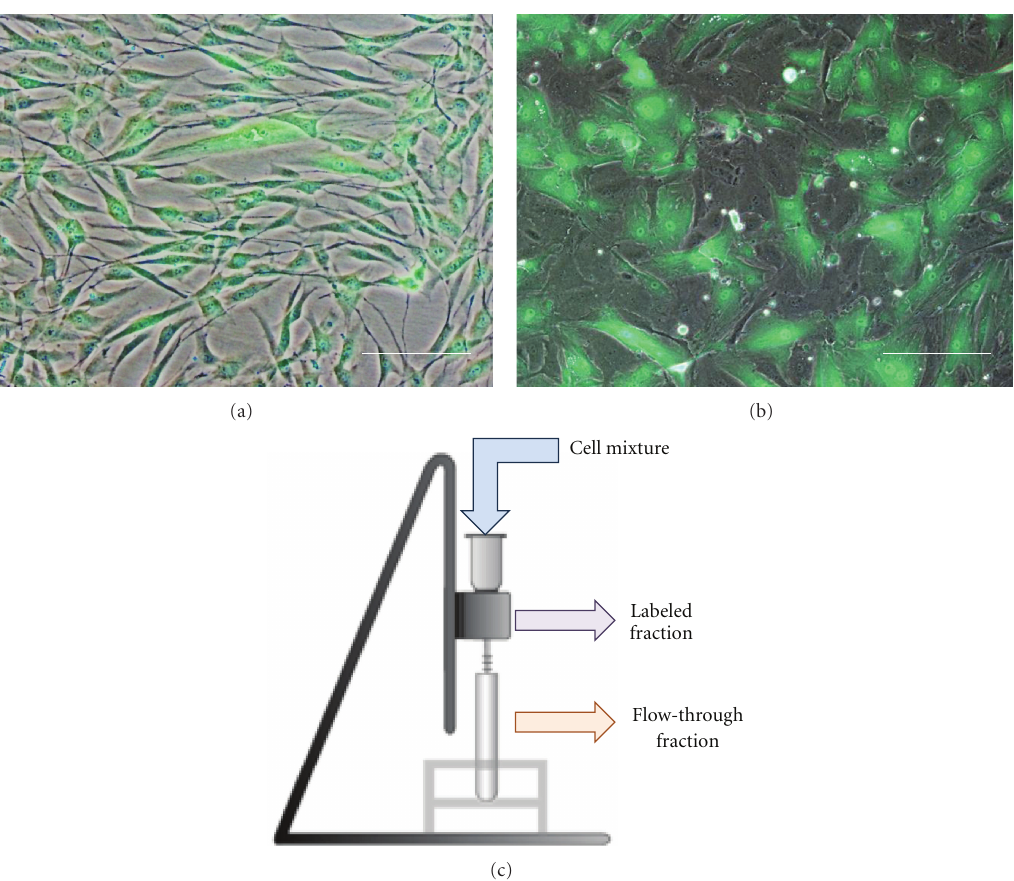
Figure 2: (a) Composite phase contrast and fluorescent picture of corneal stromal fibroblast labeled experimentally with CMFDA CellTracker Green dye. (b) Culture of CMFDA labeled corneal stromal fibroblast with human corneal endothelial cells 24 hours after mixing at a 1:1 ratio. (c) Schematic of the MACS setup used in the study (scale bar = 100 μ